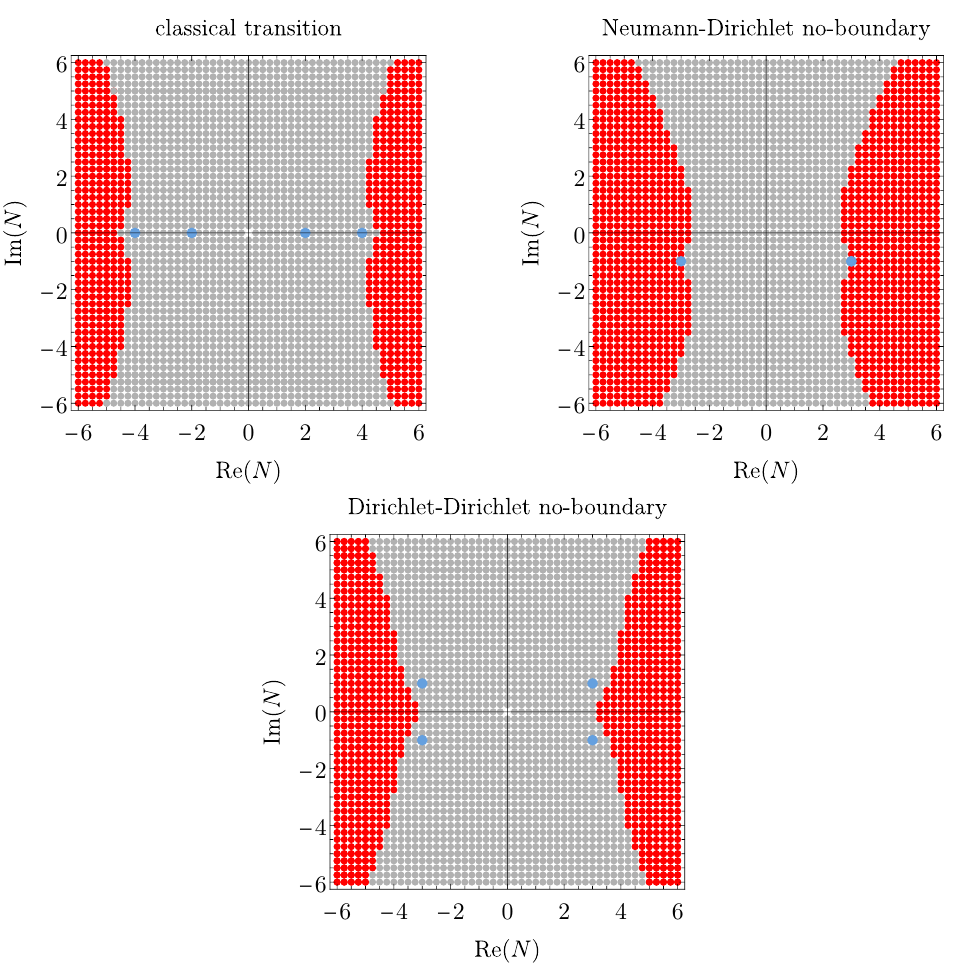
Figure 3 . Results of the walking algorithm for the different models that will be studied in this work. In red: points where a ridge is found (the LSKSW bound is violated). In grey: points where no obstruction is found, hence where further investigation is needed. Saddle points (i.e., classical solutions) are represented in